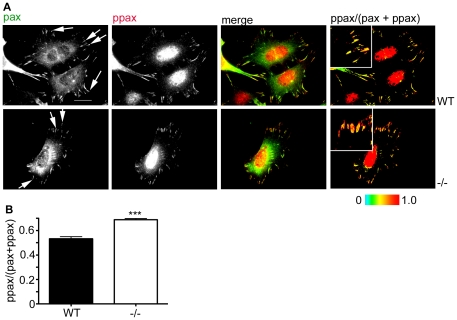
Paxillin phosphorylation is increased in NEDD9 −/− MEFs.A. Paxillin (pax) and phospho-paxillin (ppax) immunostaining. Merged images show colour overlays of paxillin (green) and phospho-paxillin (red). Right hand panels show ratio images of paxillin phosphorylation. Red hues reflect regions of highest phosphorylated paxillin. Boxed insets shows magnified focal adhesions. B. Ratio of phosphorylated paxillin at focal adhesions in WT (n = 197 from 10 individual cells) and NEDD9 −/− MEFs (n = 201 from 10 individual cells). ***p<0.0001, Students' t-test.